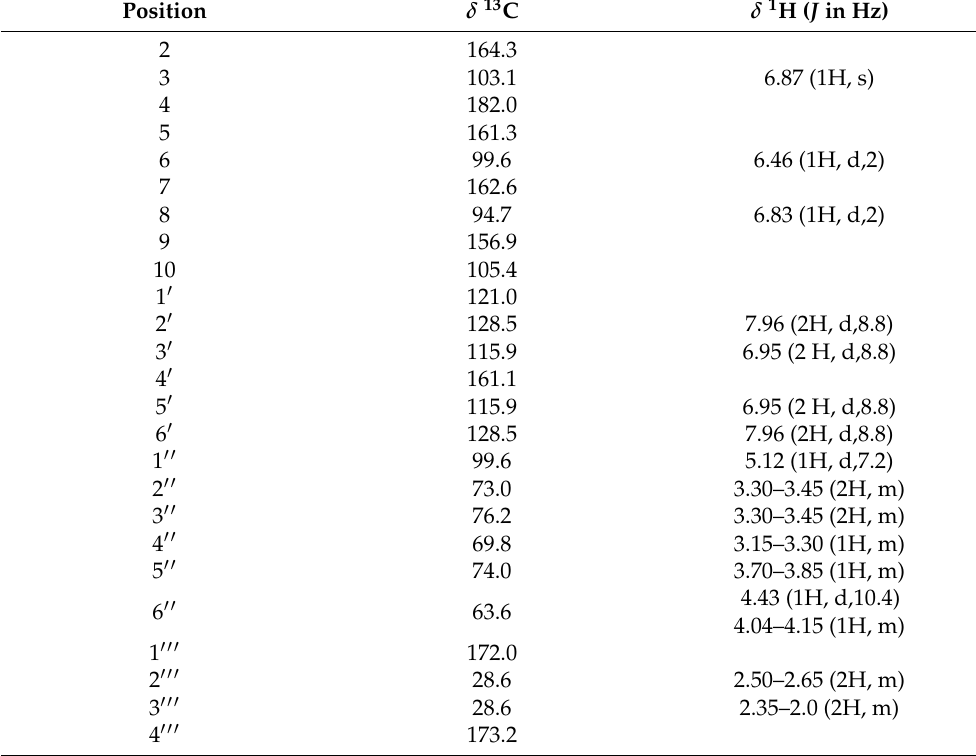
Table 1. 1 H (DMSO-d6, 400 MHz and 13 C (DMSO-d6,400 MHz) NMR of SAG in DMSO-d6. Position δ 13 C δ 1 H ( J in